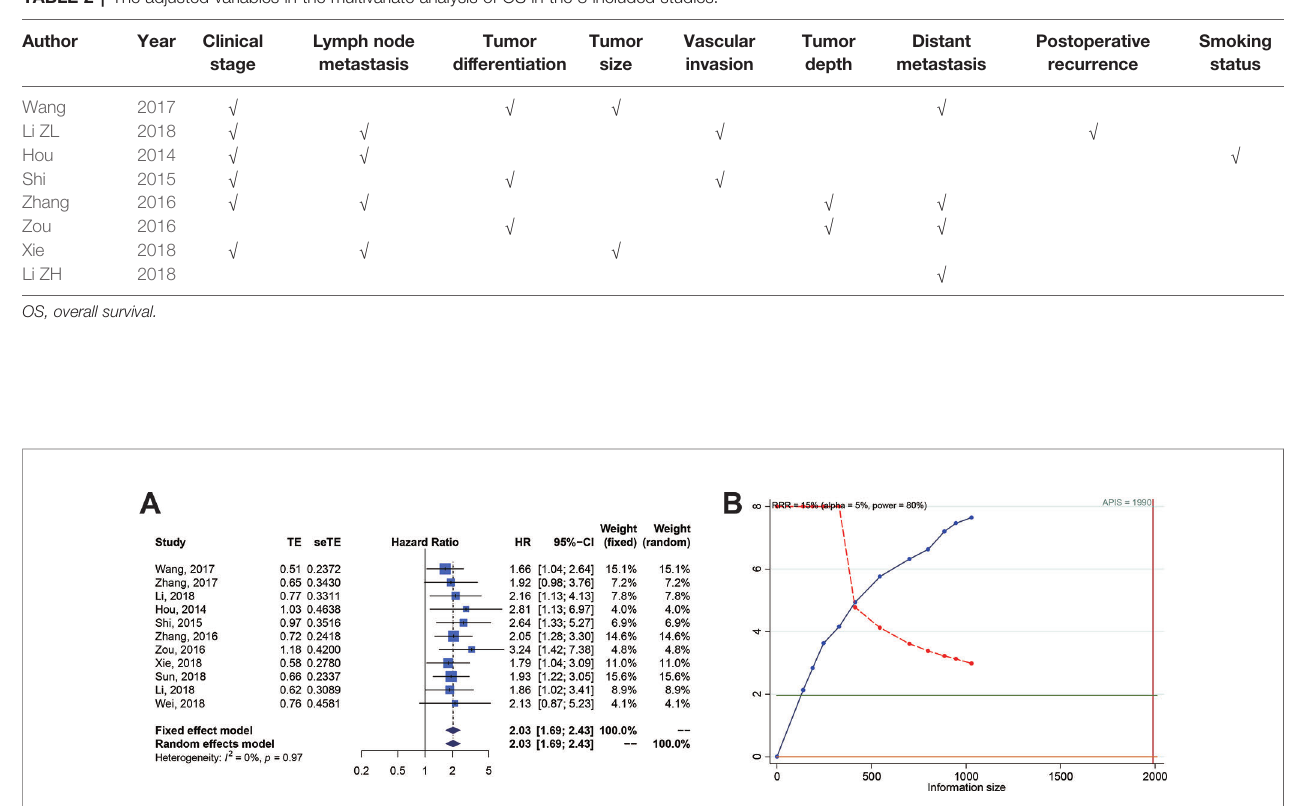
FIGURE 2 | Relationship between SOX2 overlapping transcript (SOX2-OT) expression and overall survival (OS) in patients with various cancers. (A) Forest plot of SOX2-OT expression and OS. (B) trial sequential analysis (TSA) of 11 trials comparing OS of the high vs. low SOX2-OT expression. Heterogeneity adjustment required information size of 1990 participants calculated on basis of proportion of OS of 80%, RRR of 15%, a = 5%, b = 20%, power = 0.80, and I 2 = 0%. Cumulative Z-curve crosses trial sequential monitoring boundary, showing suf fi cient evidence for a 15% increase in relative risk with high expression of SOX2-OT. Horizontal green lines illustrate the traditional level of statistical signi fi cance ( P =